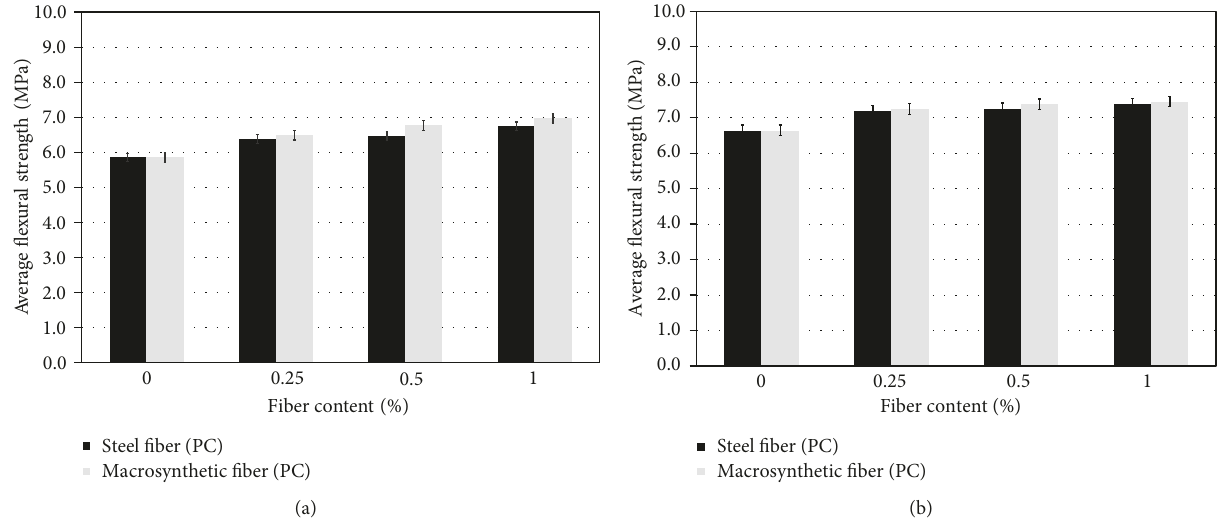
Figure 11: Flexural strength of PC segments with reinforcing types. (a) Target strength 40MPa. (b) Target strength 60MPa.